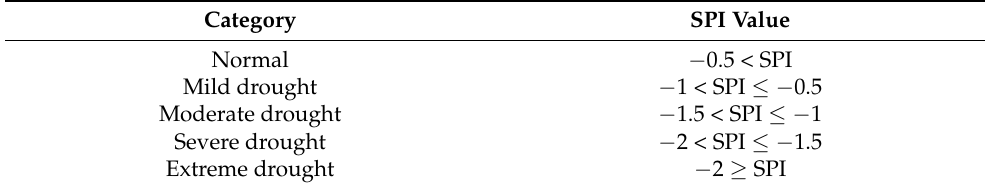
Table 1. The Drought Level